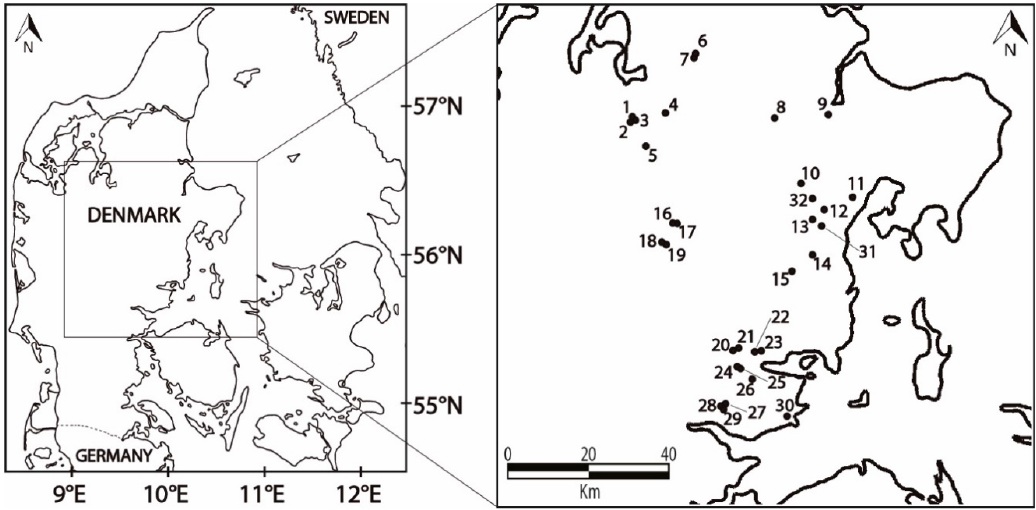
Figure 1. Overview map showing the location of the 32 sites. For names, specific locations and available data of each site, see Table 1 .